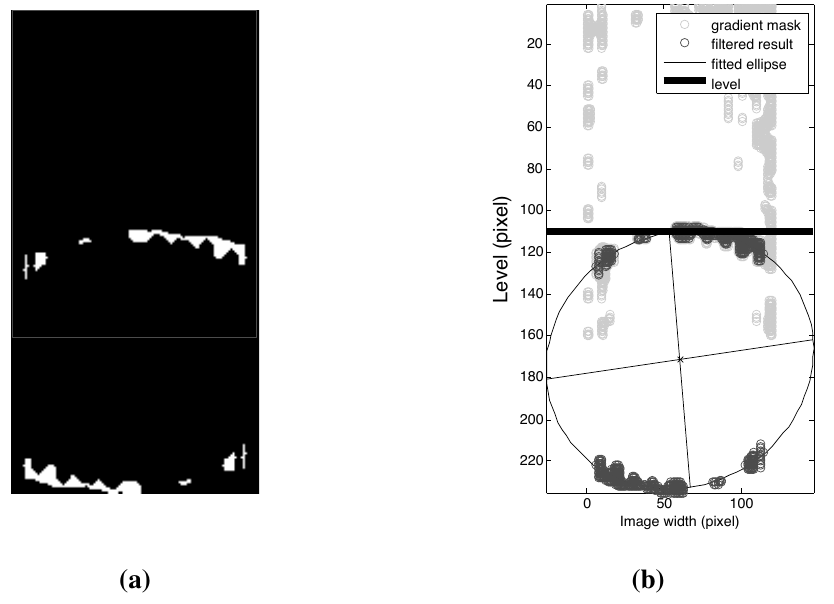
Figure 6. ( a ) Re-constructed image; ( b ) Result of ellipsoidal fitting and level